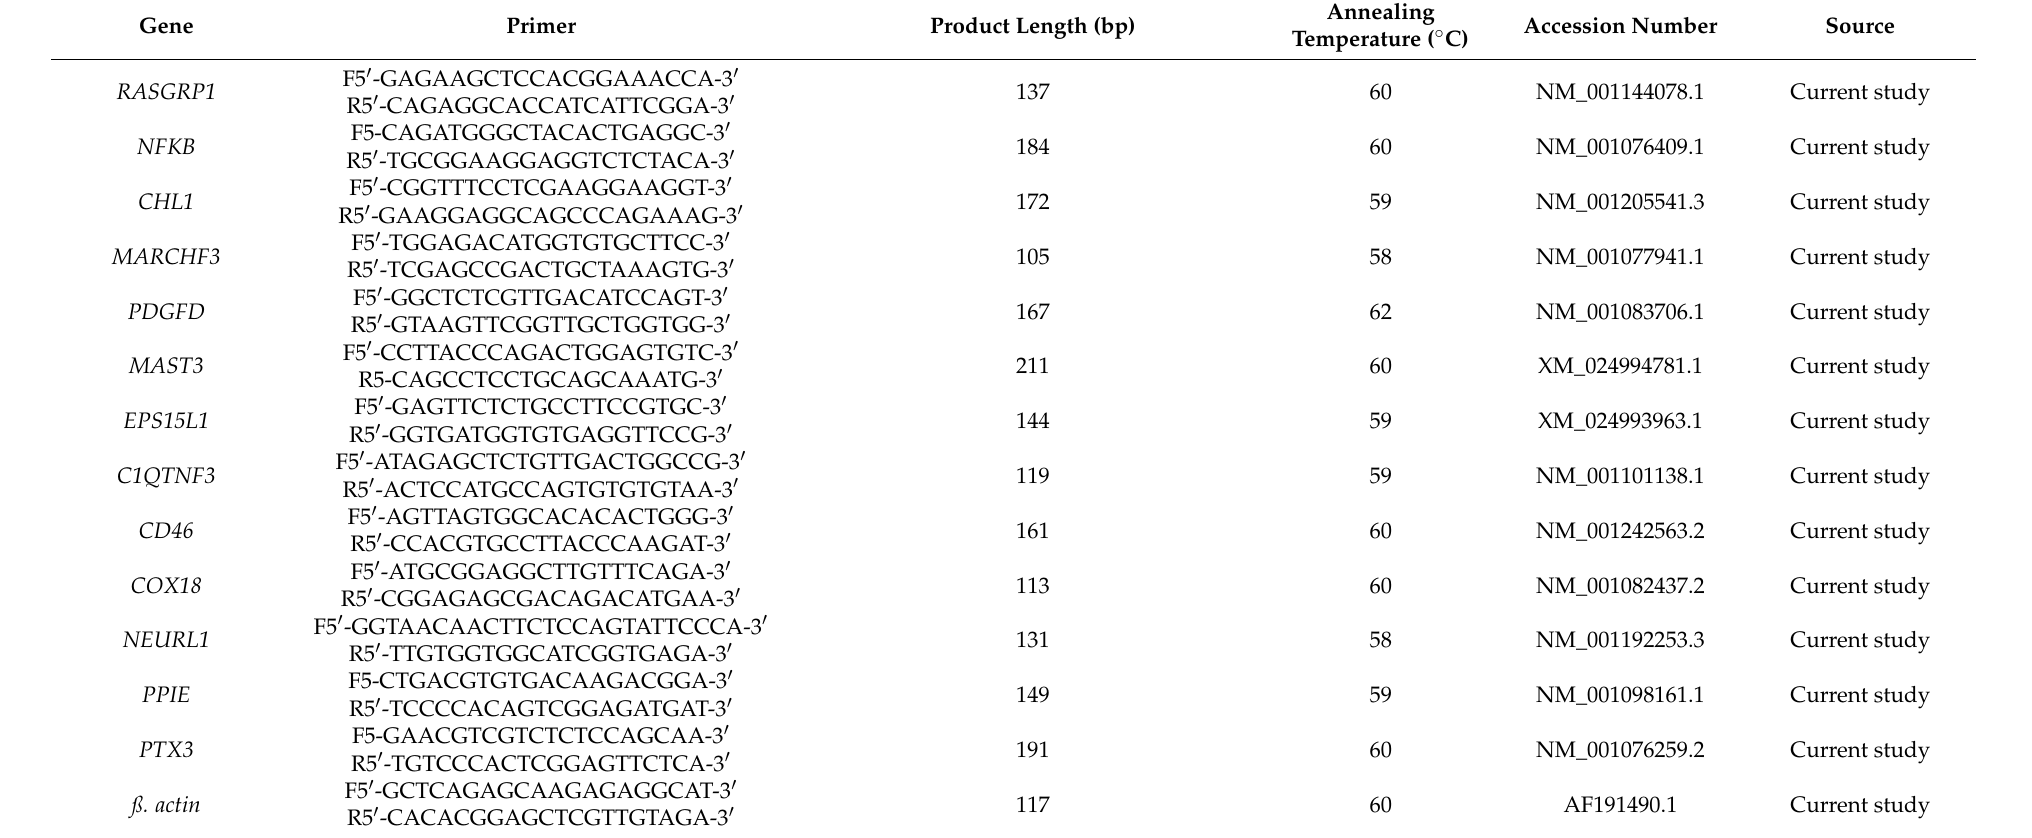
Table 2. Oligonucleotide primers sequence of investigated genes used in real time